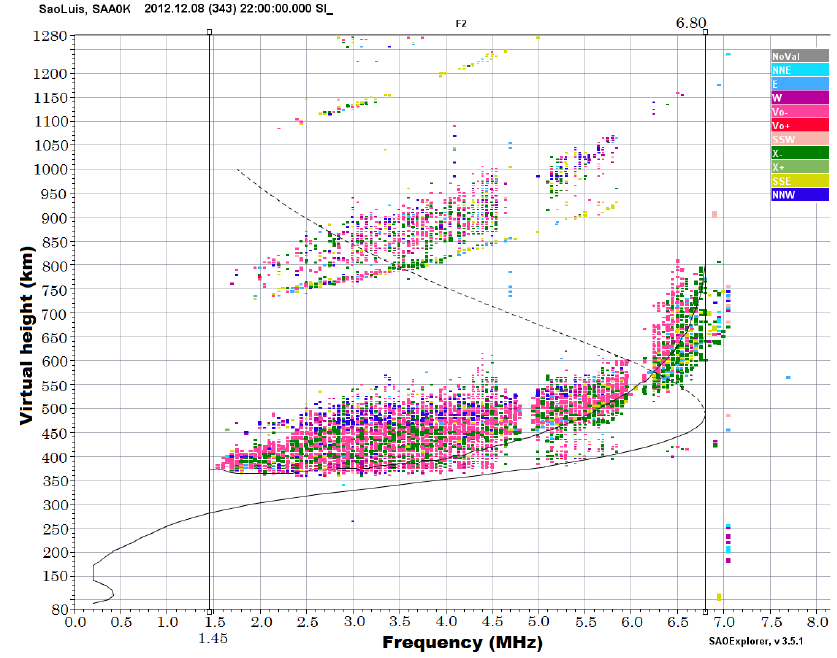
Figure 6. Ionogram obtained at São Luís at 19:00LT. The F peak height of the N e vertical profile (black dashed line) was